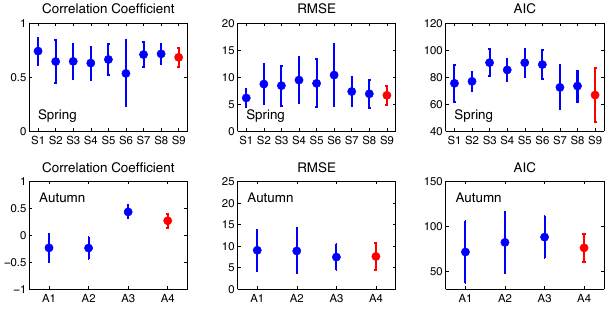
Figure 2. Comparison of model performance in the prediction of phenological dates at four US DBF sites among (top) nine spring phenology models and (bottom) four autumn phenology models. The statistical metrics are correlation coefficient, root mean square error (RMSE), and the Akaike information criterion (AIC). Each point represents the mean values of the statistical metrics at four sites for one model. The error bar represents the range of the met- rics. Each model uses the optimized parameters as summarized in Table 5 for the prediction. The red ones are the models used for the continental predictions. Detailed predictions at each site are shown in Figs. S4–S11. The values of correlation coefficients, RMSE, and AIC are summarized in Table